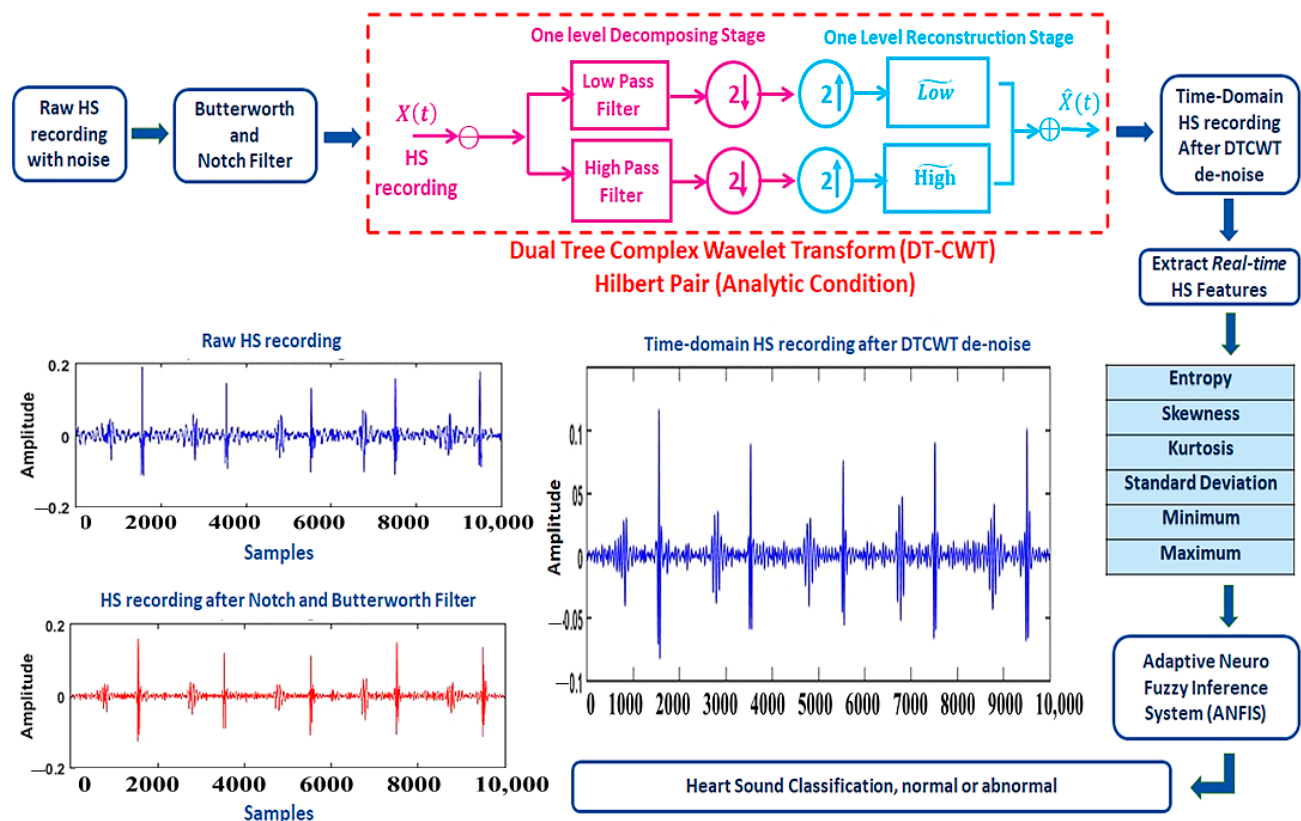
Figure 1. Block diagram of the proposed HS recordings’ denoising and ANN classifier.